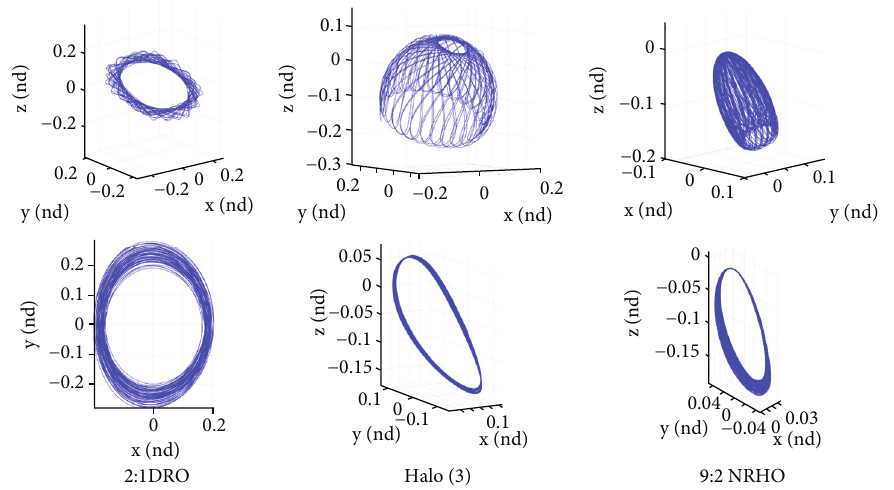
Figure 3: The re fi ned 2:1 DRO, halo (3) orbit, and 9:2 NRHO in the Moon-centered inertial frame and the Moon-centered rotating frame with the ephemeris model. Table 2: The characteristics of the re fi ned nominal orbits in the Moon-centered J2000